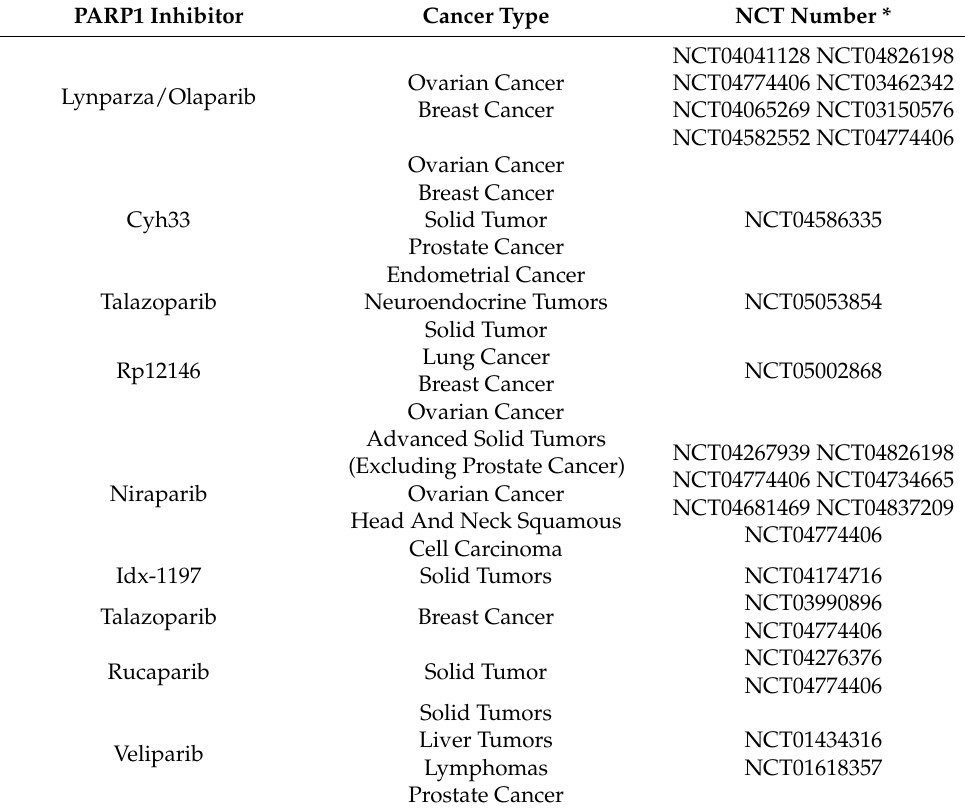
Table 2. Clinical trials of PARP1